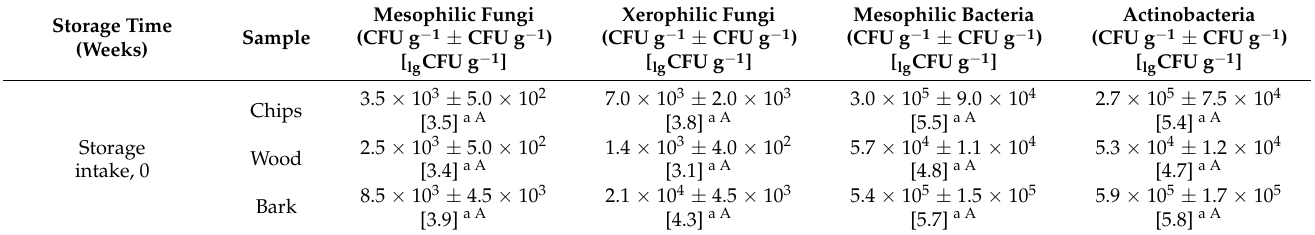
Table A4. Results of the microbiological analysis of chips, wood and bark in trial T1; presented as mean ± standard deviation, both in colony forming units per gram of sample (CFU g − 1 ). In brackets, the mean is expressed as logarithmic to base 10 ( lg CFU g − 1 ). Different small letters indicate significant differences between storage intake and end of storage ( p < 0.05). Different capital letters indicate significant differences between wood fractions at storage intake respectively at week 6 ( p <